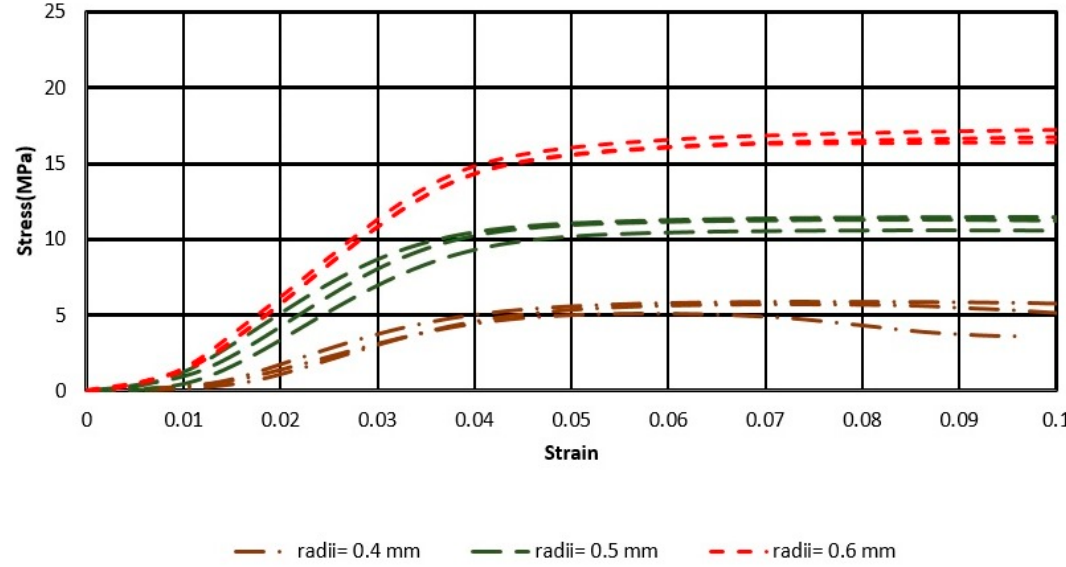
Figure 4. Stress–Strain diagram for the three samples with height-to-width ratio (H/W) = 2, of octet, with radii of struts 0.4, 0.5, and 0.6 mm.